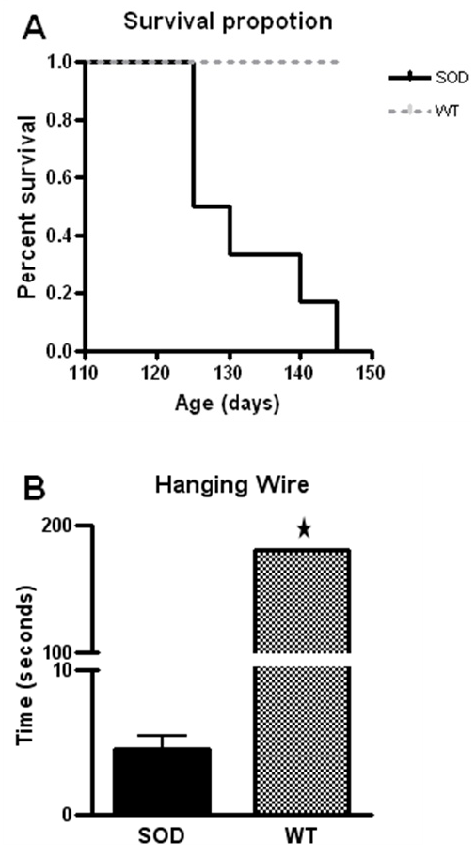
FIGURE 2 – The figure illustrates the differences in survival between mutant (SOD1) and wild-type animals ( A ) and the hanging wire test for muscle strength. The hanging wire test was expressed in terms of mean latency for each group. Data are means ± SEM. *p<0.001 (Student t test) ( B